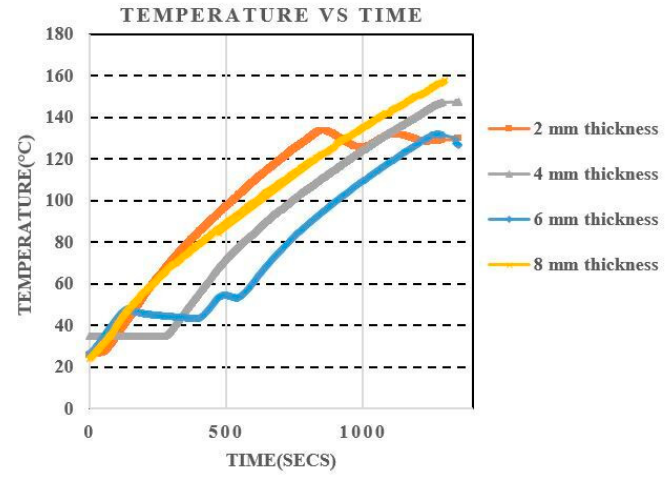
Figure 9. Temperature vibration over time for pipe samples of different thickness. Further tests were carried out on the pipe samples at room temperature and at 200 ◦ C, and the results are shown in Figure 10.